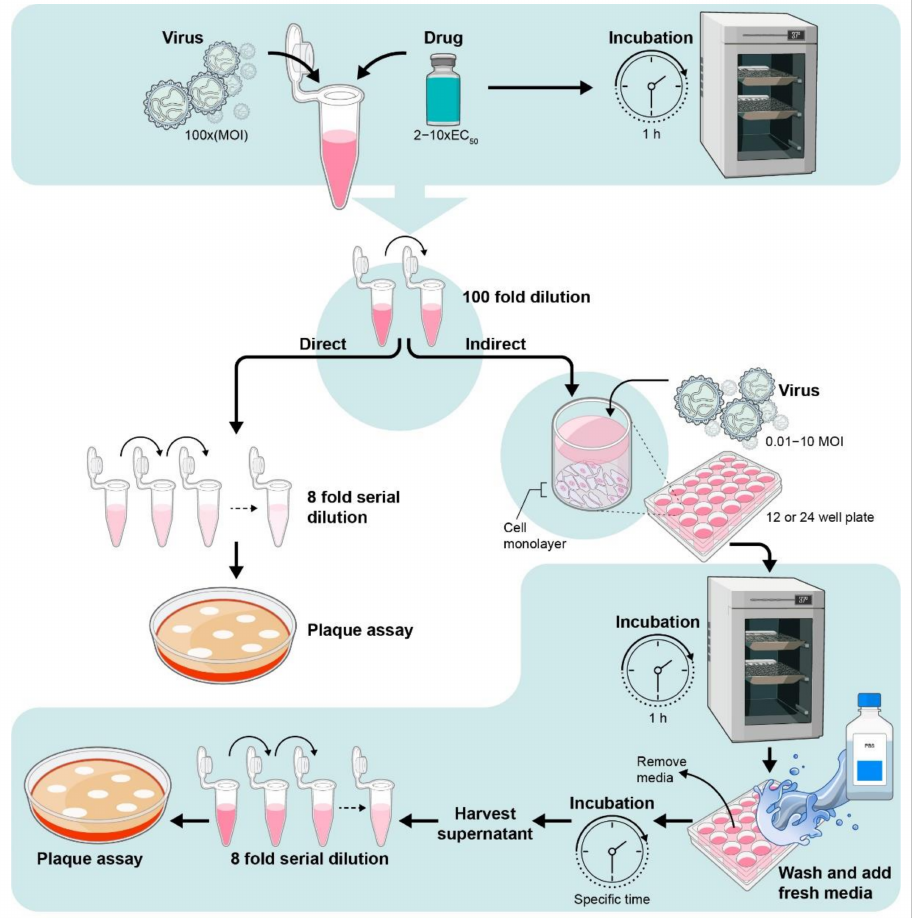
Figure 6. Schematic diagram of the virus inactivation